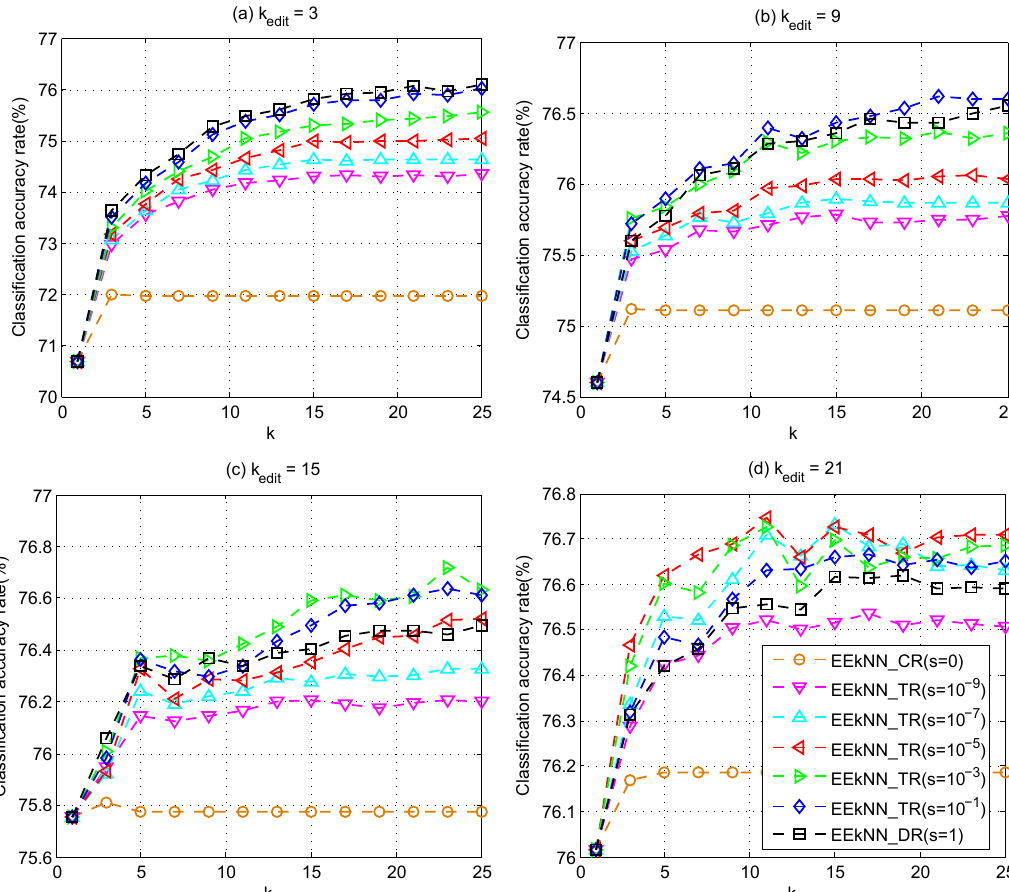
Figure 3. Classification results for different combination rules under different k edit values with values of k ranging from